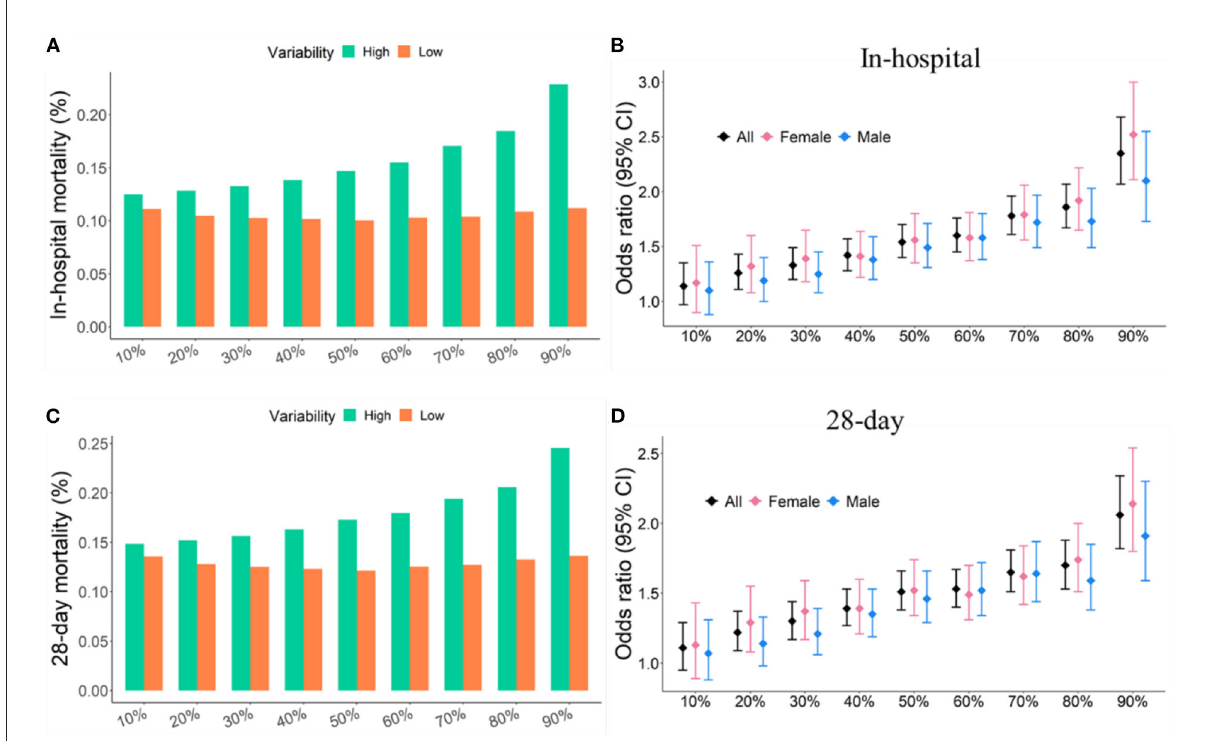
FIGURE2 Short-term mortality and odds ratios were increased with increasing quantile of MAP variability. (A,C) Short-term mortality as a function of different quantiles of CV. (B,D) Odd ratio as a function of different quantiles of CV. Study participants were divided into two groups: high variability ( ≥ a given quantile of CV) and low variability ( < a given quantile of